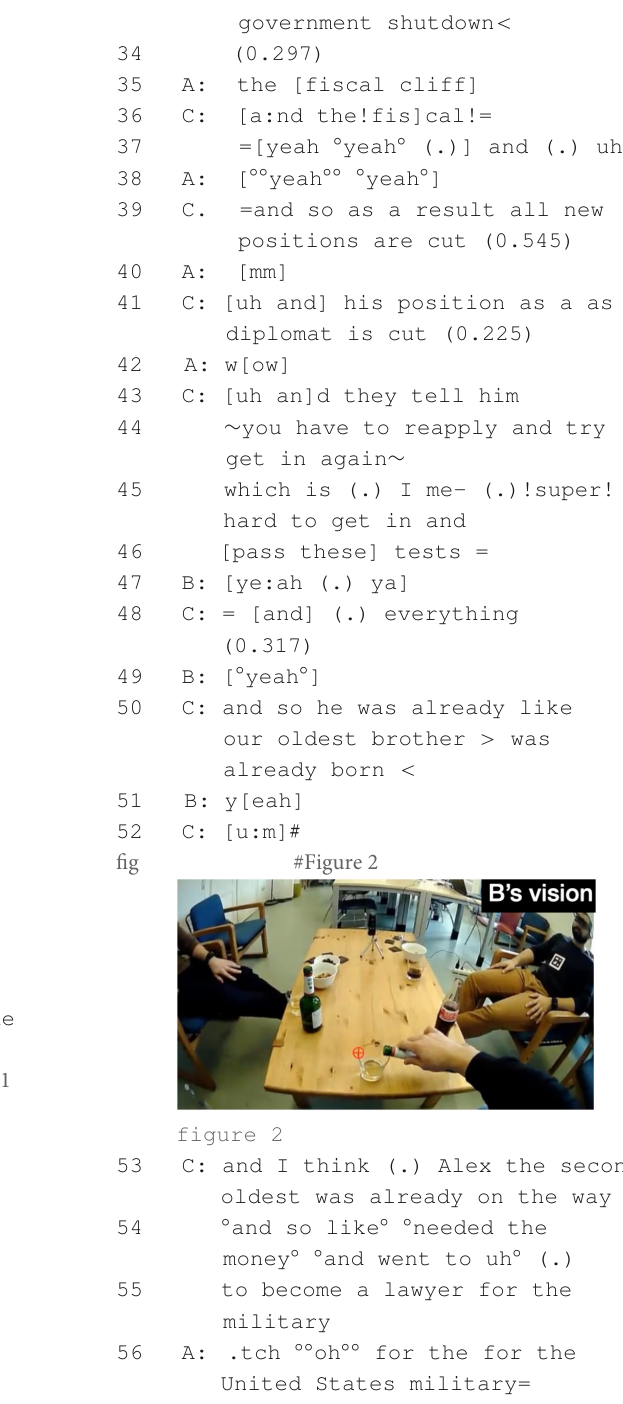
A: .tch ◦◦ oh ◦◦ for the for the United States military= C: